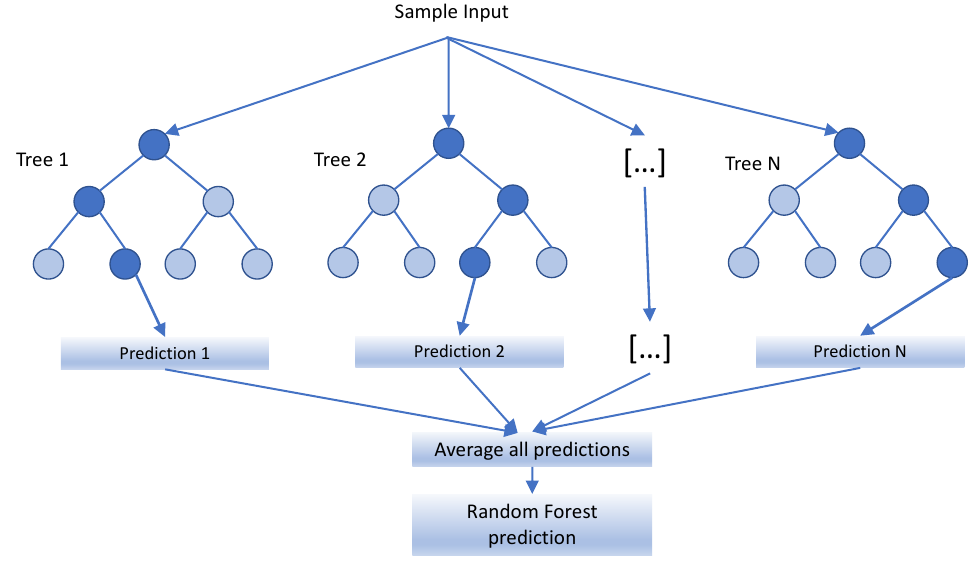
Figure 3. Random forest prediction